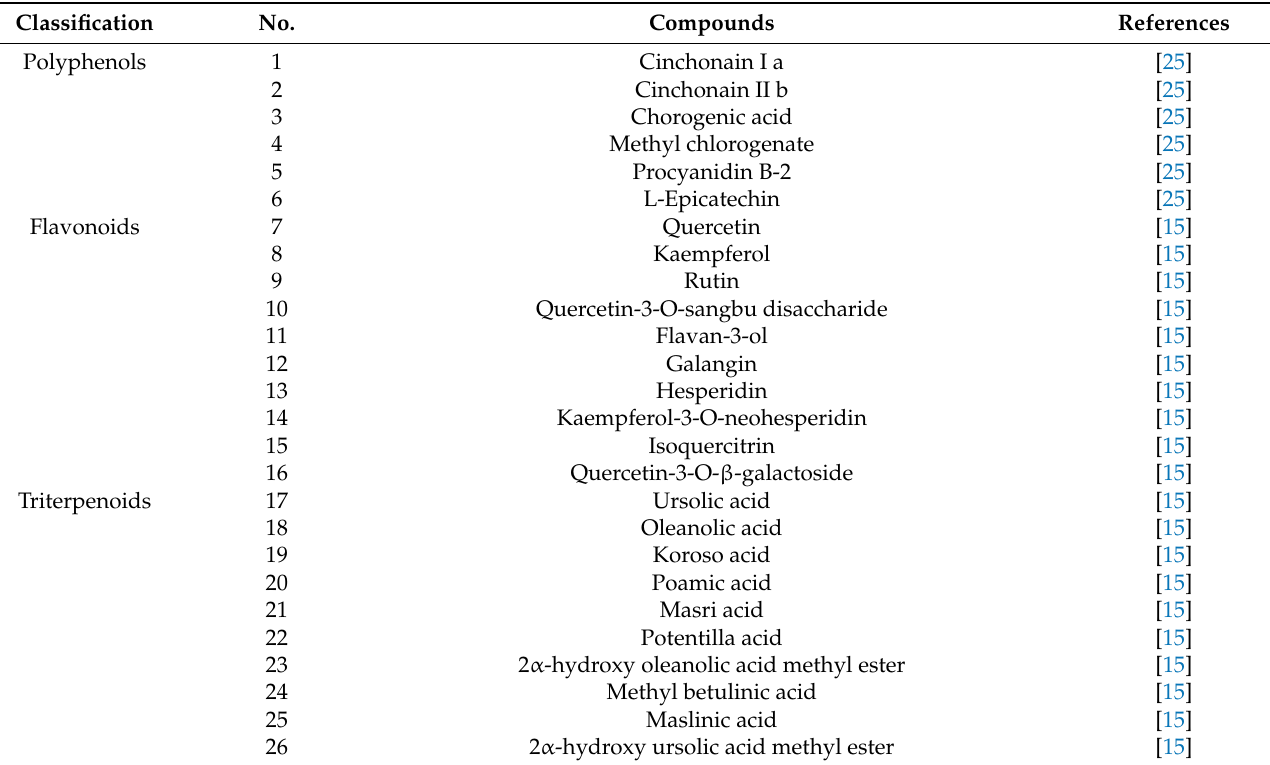
Table 1. The main compounds in loquat leave.